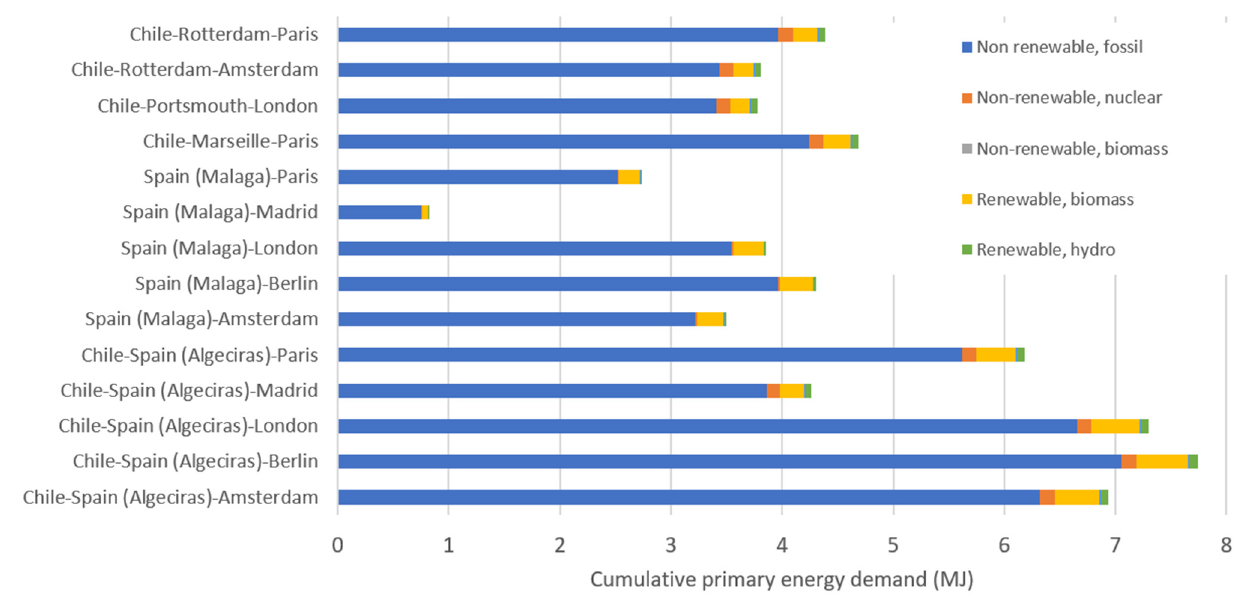
Figure 3. Cumulative primary energy demand (MJ) for the different routes of transport of 1 kg of avocados. Chile and Spain are considered as the travel origin; for Chile two options are considered: (i) export via Algeciras port and then using the same route as Spain exports (lower five bars) and (ii) export via Rotterdam, Portsmouth, or Marseille (as indicated in the four upper bars) and the road to the respective city.